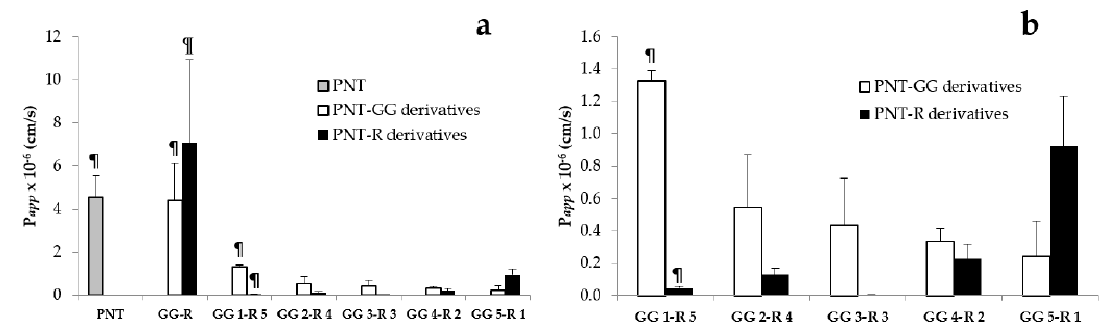
Figure 3. ( a ) Permeability coefficients of PNT and analogues. ( b ) Magnification of permeability coefficients of decapeptides. (¶ indicates the presence of translocation fragment KKWKMRR; PNT in grey, PNT-GG derivatives in white, PNT-R derivatives in black; mean value ± sem).